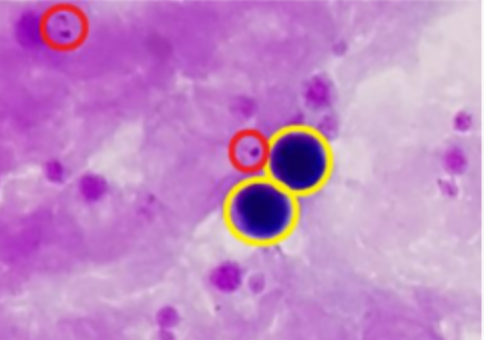
Figure 1. Thick blood smear. Red circles are trophozoites and yellow circles are White Blood Cells (WBCs)